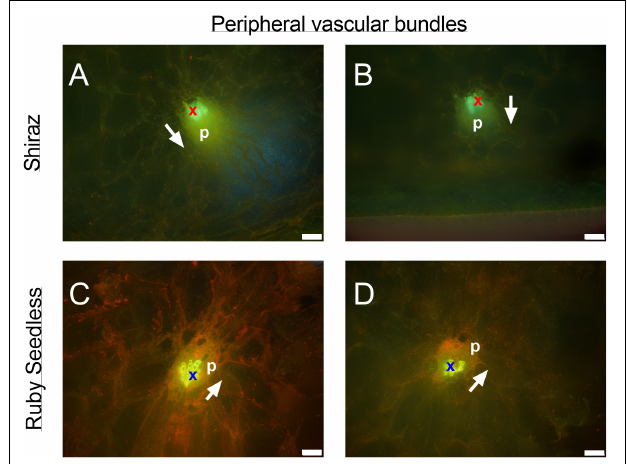
FIGURE 8 | Peripheral bundles at the equator of the berries in pre-veraison (44 DAA) Ruby Seedless (A,B) and post-veraison (85 DAA) Shiraz (C,D) berries. Bright green indicates auto-fluorescent xylem vessels (x) adjacent to yellowish green phloem tissue (p) within each peripheral vascular bundle. White arrows point toward the position of the epidermis. Excitation filter 330–385 nm, dichroic mirror 400 nm, barrier filter 420 nm. Scale bar = 50 µ